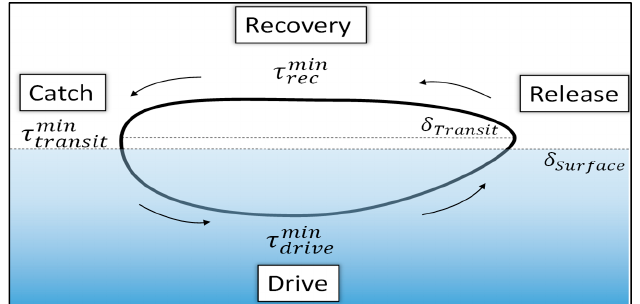
Figure 4. Illustration of the vertical oar rotation-dependent rope tension adjustment for the tendon based parallel robot. A typical rowing cycle is illustrated with the thick elliptic line. Four arrows show the direction of the oar blade within the cycle.